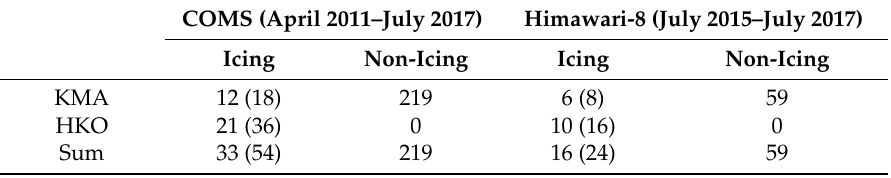
Table 3. PIREP data used to develop icing detection models for COMS and Himawari-8. Values in parentheses are the number of icing PIREPs before conducting quality control, while the values in front of the parentheses are the number of icing PIREPs after the quality